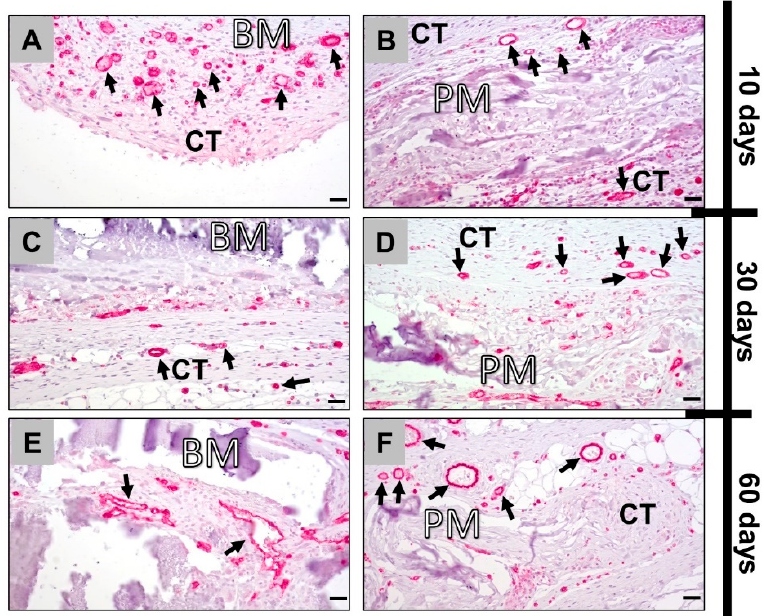
Figure 4. Immunohistochemically stained slides show detection of CD31-positive endothelial cells into the implantation beds of both bovine (left column: A , C and E ) and porcine collagen mem- into the implantation beds of both bovine (left column: A , C , E ) and porcine collagen membranes branes (right column: B , D and F ) at days 10, 30 and 60 after implantation (all images: 400 × magni- (right column: B , D , F ) at days 10, 30 and 60 after implantation (all images: 400 × magnification; fication; scalebars = 20 μ m). CT: connective tissue; BM: bovine membrane; PM: porcine membrane; scalebars = 20 µ m). CT: connective tissue; BM: bovine membrane; PM: porcine membrane; black black arrows: CD31-positive vessels. arrows: CD31-positive vessels.